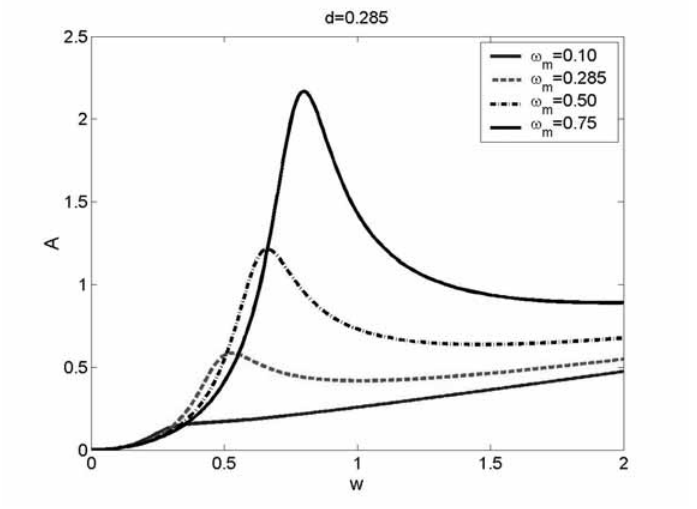
Fig. 15. Absolute engine mass acceleration.